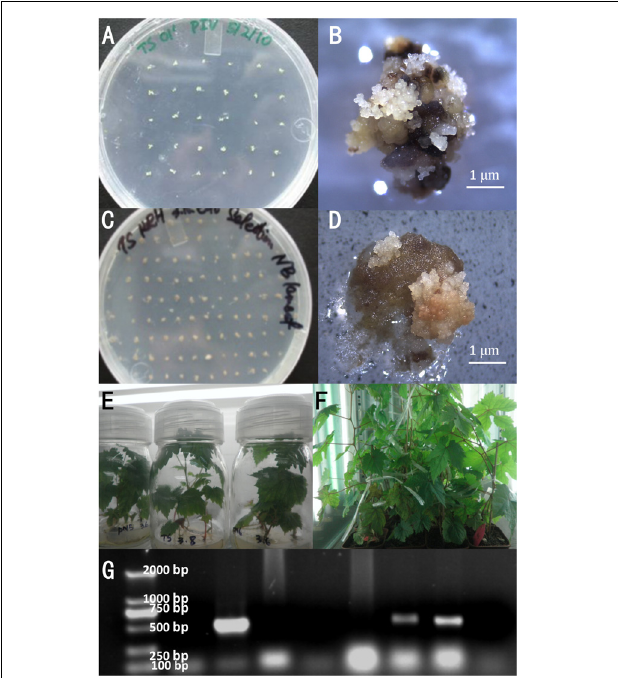
FIGURE 3 | Transformation and selection of plants. Separated anthers were inoculated on PIV medium (A) . Induced somatic embryogenic culture from anthers after cultivation (B) . Callus of Thompson seedless on the selection medium for 2 months after transformation with the VaNCED1 gene (C) and enlarged view (D) . Regenerated wild-type (WT) and putative transgenic plants in vitro (E) and in soil (F) . Validation of putative transgenic plants by PCR amplification of the nos terminator (G) . M, DL2000 marker; WT, wild-type negative control; P, plasmid pBI121-VaNCED1; 1–6, putative transgenic grapevine lines. Bar = 1